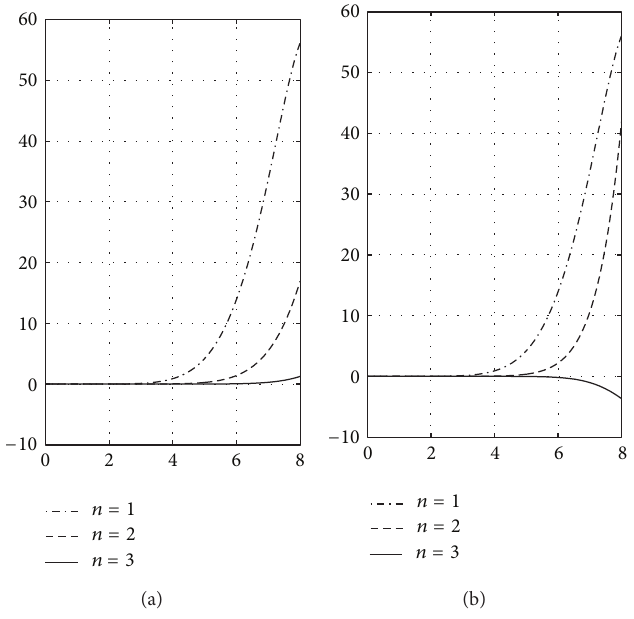
Figure 2: The error functions 𝐸 𝑛 (𝑡 𝑖 ) for Example 2: (a) present method and (b) standard